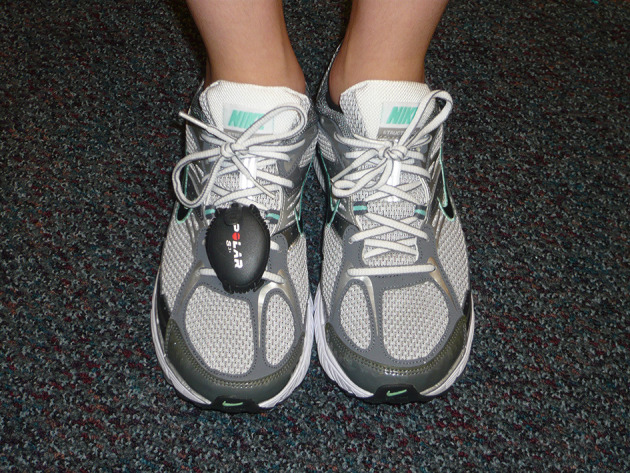
Placement of the S3+ Stride Sensor secured to the shoelaces of the right shoe.